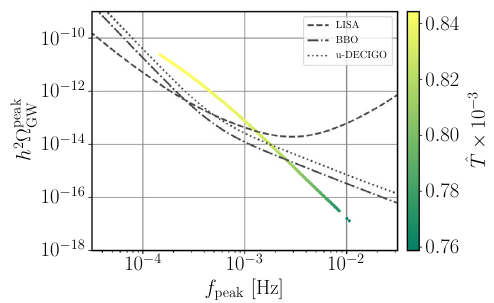
Fig. 1 Parametric scan displayed in ˆ T , which varies within the range [ 0 . 76 , 0 . 84 ] × 10 − 3